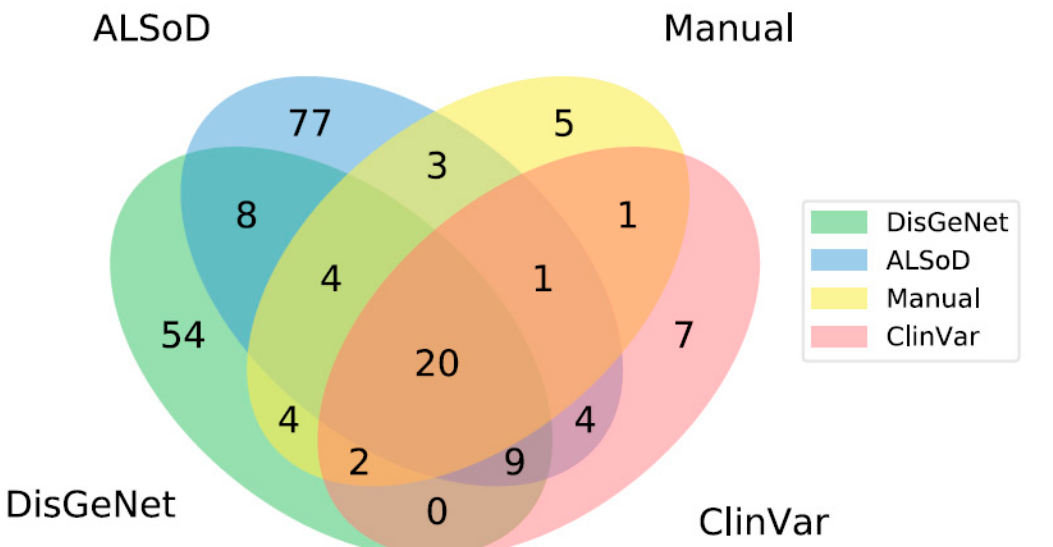
Figure 1. Overlap between lists of ALS-linked genes from different sources. Note that areas are not to scale. There are no genes that are listed in both ClinVar and DisGeNet but not found in either ALSoD or the manual review. In total, there are 199 unique genes linked to ALS across all lists.